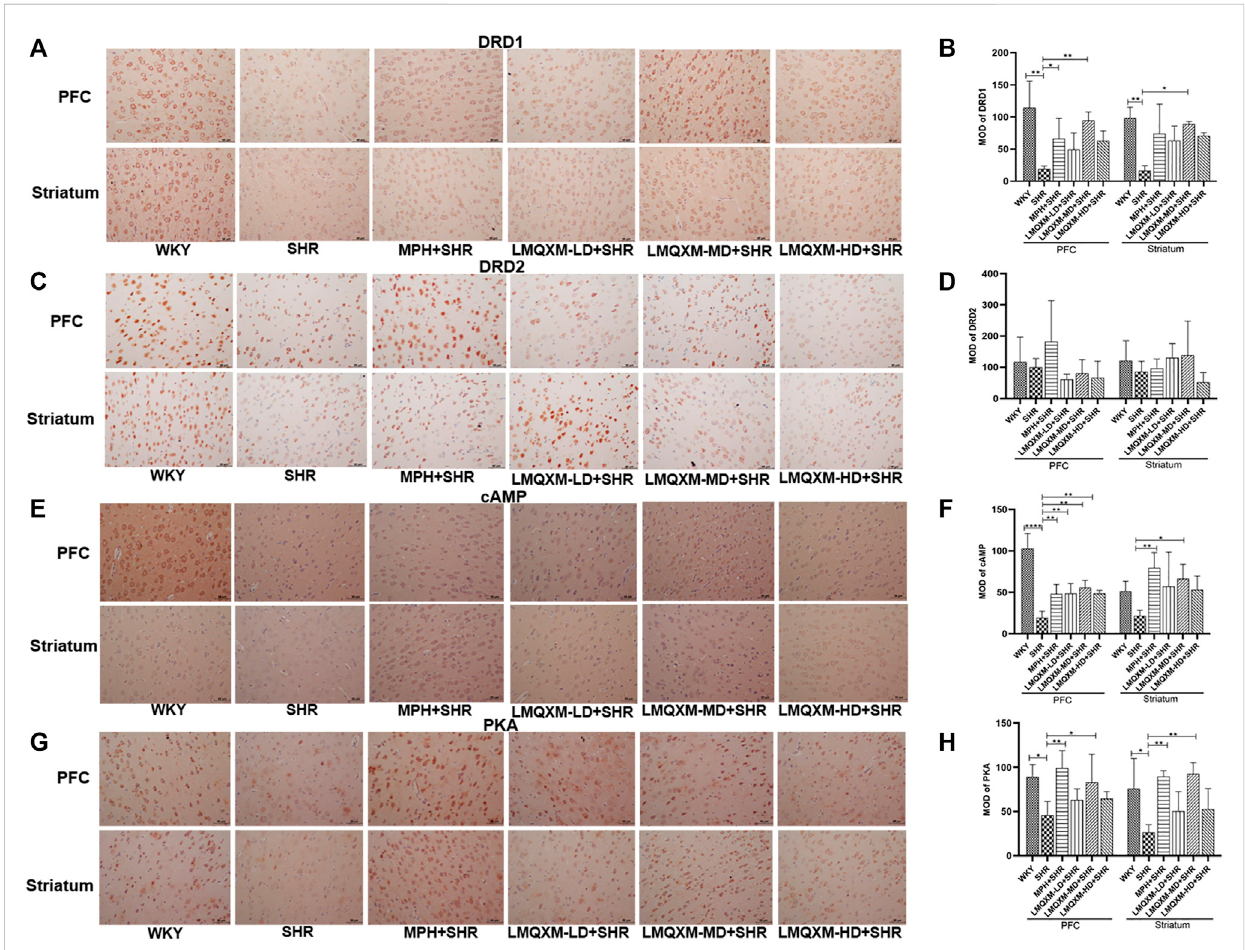
FIGURE 8 Immunohistochemical index results in PFC and striatum for each group of rats (A) DRD1 positive expression image from PFC and striatum (B) MOD quanti fi cation from DRD1 in PFC and striatum (C) DRD2 positive expression image from PFC and striatum (D) MOD quanti fi cation from DRD1 in PFC and striatum (E) cAMP positive expression image from PFC and striatum (F) MOD quanti fi cation from cAMP in PFCand striatum (G) PKA positive expression image from PFC and striatum (H) MOD quanti fi cation from PKA in PFC and striatum. The positive expression is brown yellow, and all data are presented as mean ± SD, n = 3 for each group. * p < 0.05, ** p < 0.01, *** p < 0.001, **** p < 0.0001.